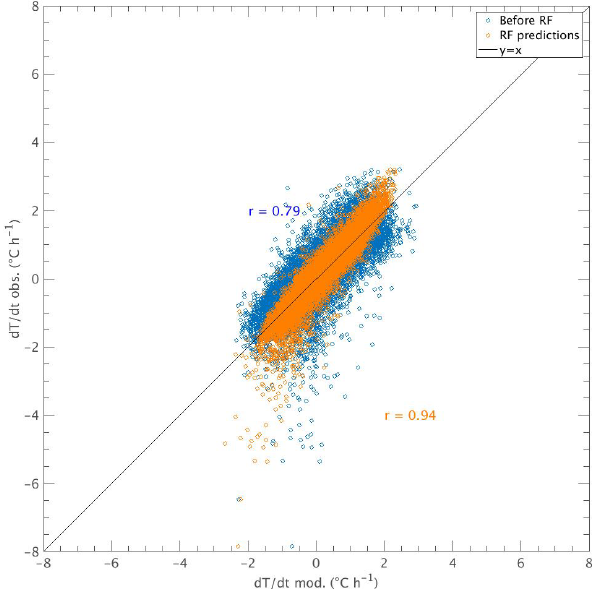
Figure 7. Scatter plot of ∂T 2m as a function of the developed ∂t obs model ∂T 2m before applying the random forest method (blue ∂t mod circles) and ∂T 2m as a function of the model trained after the RF ∂t obs method is applied (orange